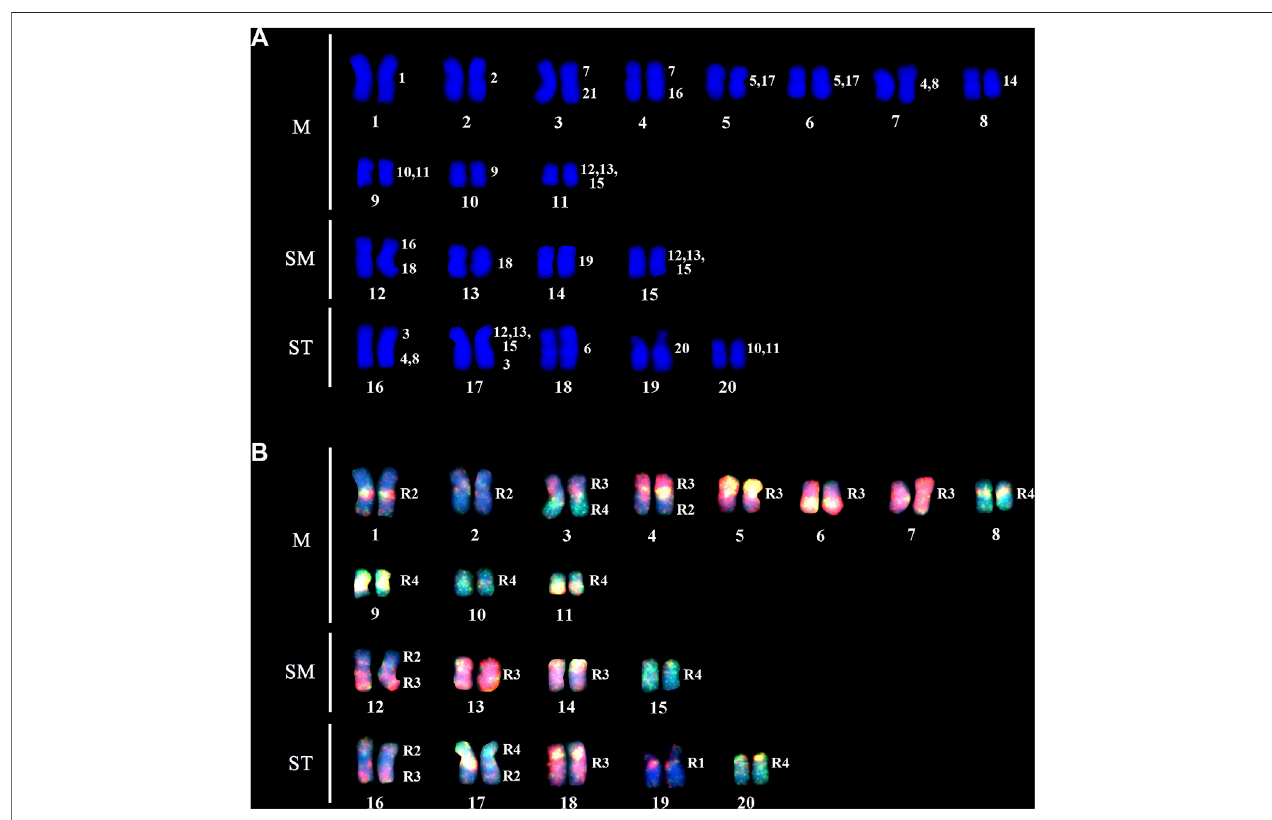
FIGURE2|(A) ADAPIstainedkaryotypeofGCC;thenumbers ontheright represent the G. carapo(GCA42) equivalent chromosomes. (B) Dualcolor fi shwiththe probes of R3 (pairs 4 – 8 and 17 – 19; red) and R4 (pairs 9 – 15 and 21; green). Chromosome segments hybridizing with 2 colors indicate repetitive DNA sequences.